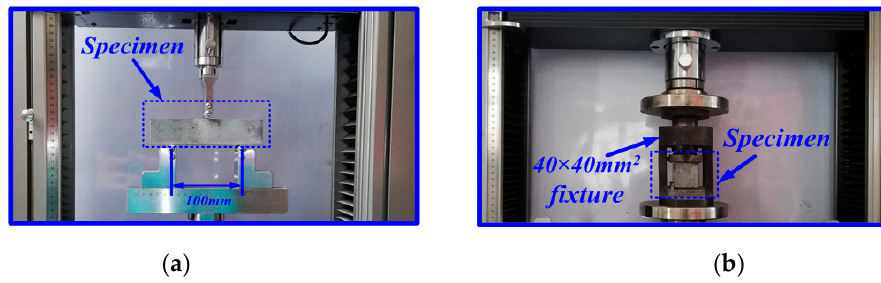
Figure 2. Loading setup of the flexural strength ( a ) and compressive strength tests ( b ). Materials 2020 , 13 , x FOR PEER REVIEW